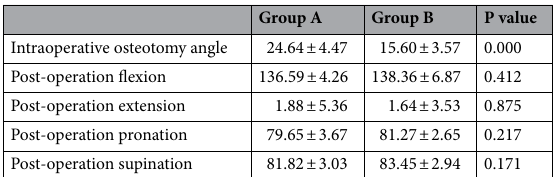
Table 3. Comparison between two group in Intraoperative ulnar osteotomy angle and Post-operation